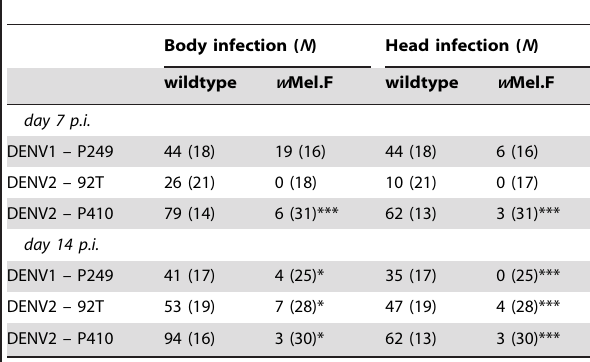
between field Wolbachia -infected ( w Mel.F) and uninfected (wildtype) mosquito lines at days 7 and 14 p.i. (experiment